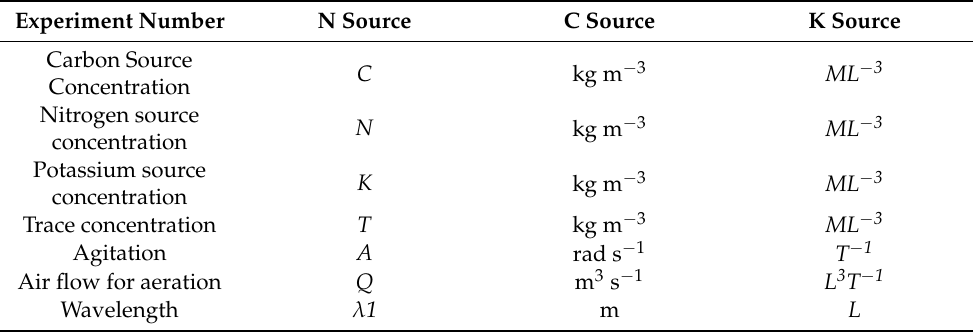
Table 5. Variables and dimensions used in the application of Buckingham’s Pi theorem. Experiment